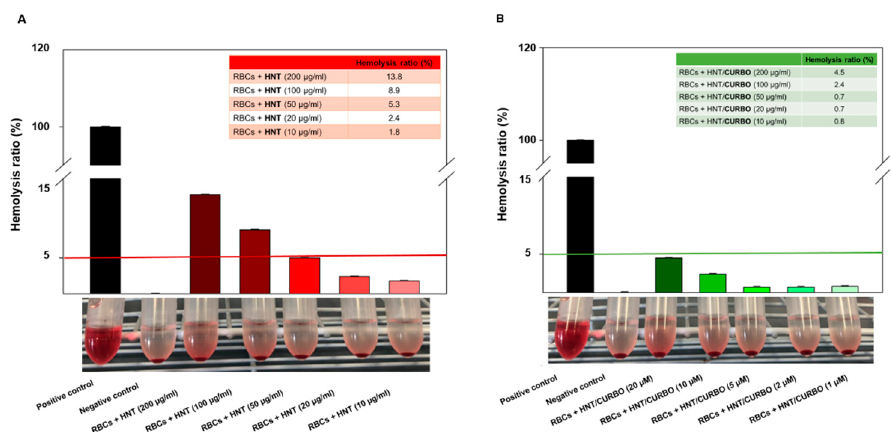
Figure 4. In vitro hemocompatibility assay of ( A ) raw HNT and ( B ) HNT/CURBO after incubation at 37 ◦ C for 12 h. The positive control was in ultrapure water (100% lysis), and negative control was in PBS 1 × (0% lysis). International Journal of NanoMedicine 2021:16 4755–4768 Originally published by and used with permission from Dove Medical Press Ltd. [88].